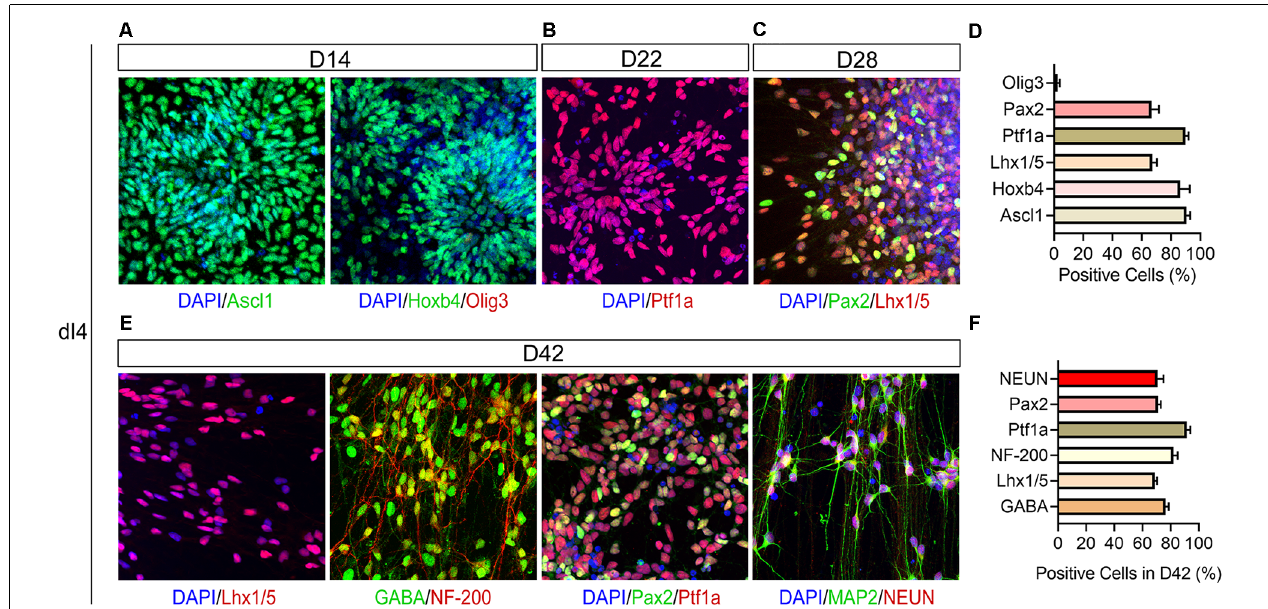
FIGURE 3 | Immunophenotyping of hPSC-derived dI4 INs. (A) Confocal images showing expression of Ascl1, Hoxb4, and Olig3 at D14; Ptf1a (B) at D22, Pax2 and Lhx1/5 (C) in dI4 neural progenitors at D28. (D) The percentage of positive cells in (A–C) . (E) Immunostaining of differentiated dI4 mature neurons for GABA, NF-200, Pax2, Lhx1/5, NEUN, and MAP2 at D42. (F) The percentage of positive cells in (E) . Scale bar, 50 µ m. Data are presented as mean ± SEM of three independent experiments.